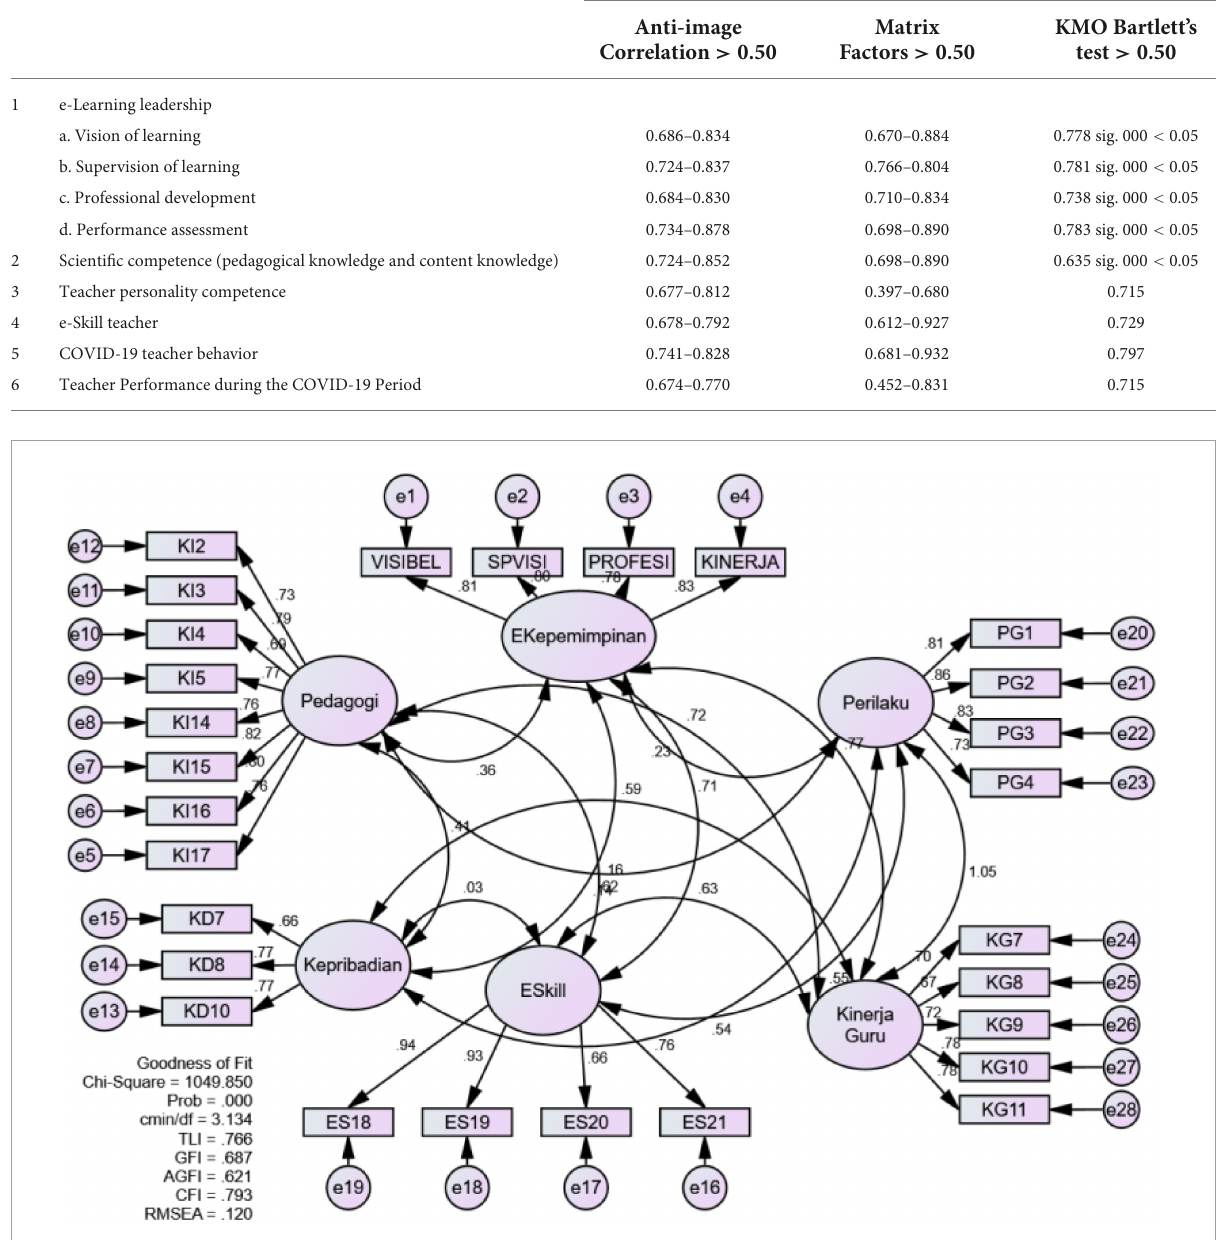
FIGURE1 Diagram of measurement model analysis results from indicators to